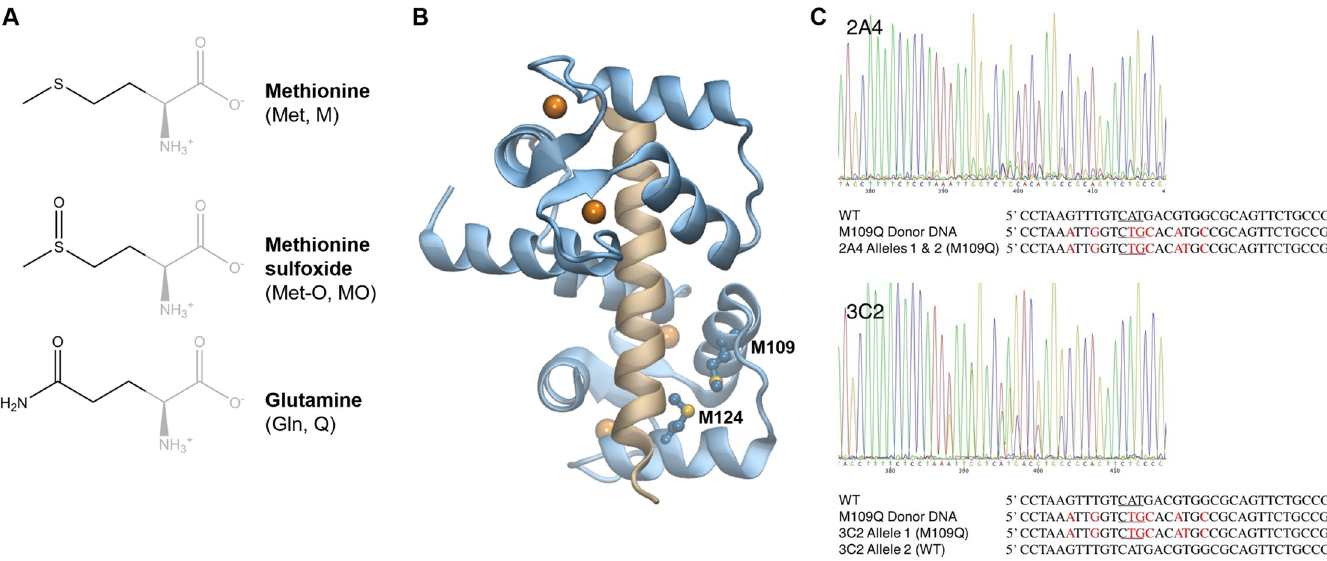
Fig 1. CALM1 gene editing in mouse myoblasts. (A) Methionine can be oxidized to methionine sulfoxide by cellular oxidants; glutamine substitution mimics methionine sulfoxide. (B) Structural models of CaM (blue) bound to the RyR peptide (tan) with four bound Ca 2+ atoms (orange); CaM Met 109 and Met 124 sidechains are shown (PDB: 1BCX). (C) CRISPR-Cas 9 editing of C2C12 myoblasts. Sanger sequencing of the target region in CALM1 for the 2A4 and 3C2 cell lines. The wild type (WT) sequence, donor DNA sequence, and the mutant sequences are shown (antisense). Mutations are indicated in red. Nucleotides encoding M109(Q) are underlined in